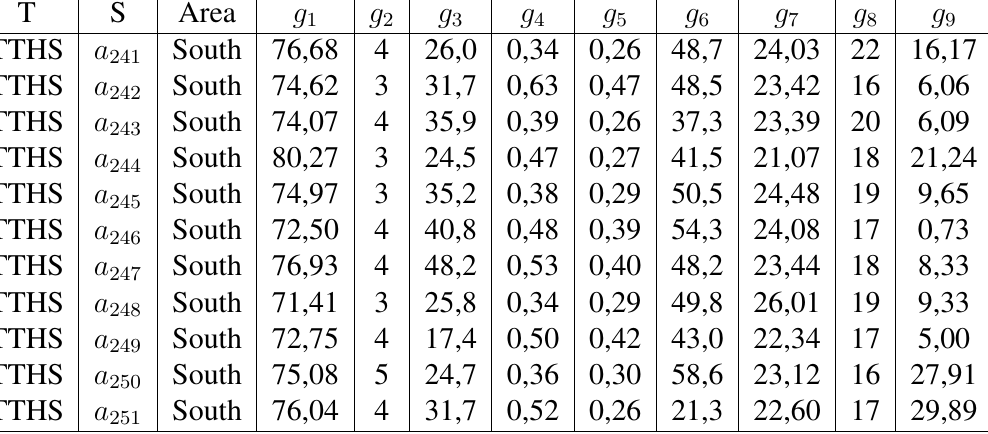
Table 7: Evaluation table of g